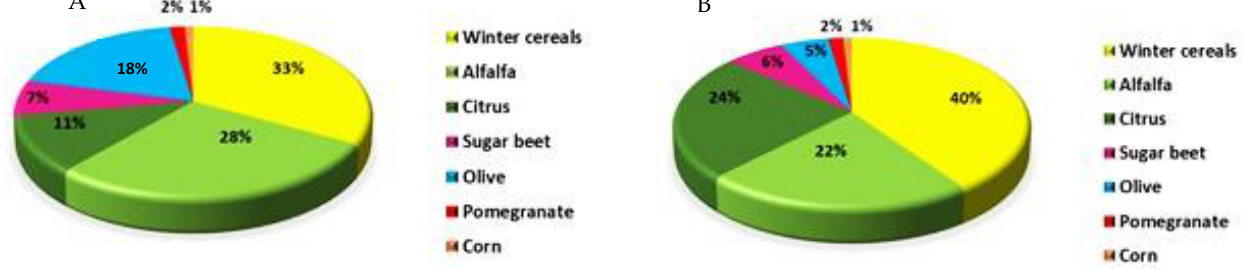
Figure 13. Spatial contribution of major crops in the Tadla Irrigated Perimeter for the year 2020/2021. ( A ) Measured contribution, ( B ) Estimated contribution.